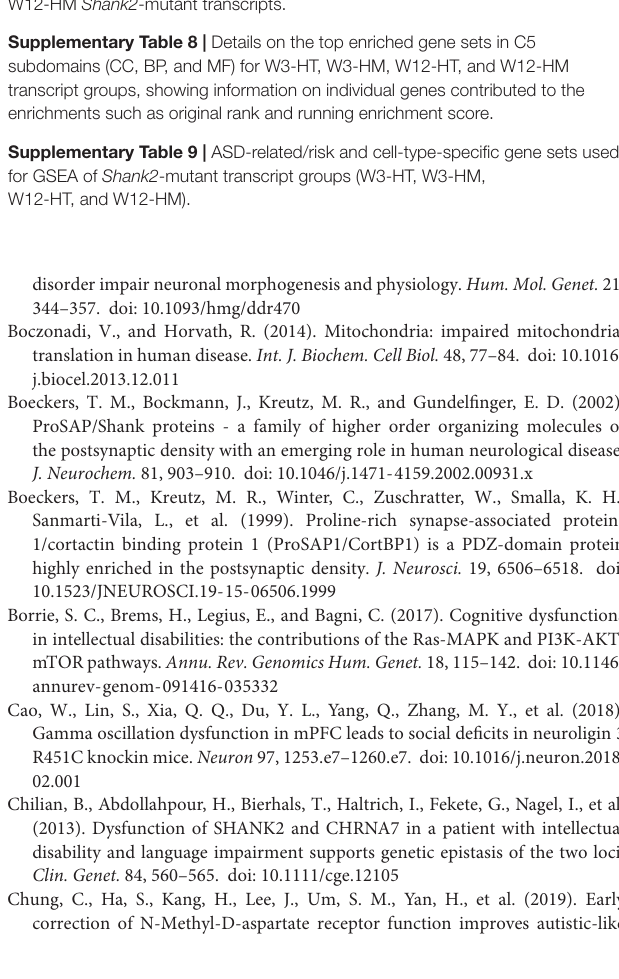
Supplementary Figure 2 | GSEA of transcriptomes from W3-HT Shank2 -mutant mice for biological functions in the C5-BP (biological process) domain. (A,B) GSEA results for W3-HT transcripts showing the list of top five positively (red) and negatively (blue) enriched gene sets (A) and their integrated visualization generated using Cytoscape EnrichmentMap App (B) ( n = 5 mice for WT, HT, and HM, FDR < 0.05). Supplementary Figure 3 | GSEA of transcriptomes from W3-HT Shank2 -mutant mice for biological functions in the C5-MF (molecular function) domain. (A,B) GSEA results for W3-HT transcripts showing the list of top five positively (red) and negatively (blue) enriched gene sets (A) and their integrated visualization generated using Cytoscape EnrichmentMap App (B) ( n = 5 mice for WT, HT, and HM, FDR < 0.05). Supplementary Figure 4 | GSEA of transcriptomes from W3-HM Shank2 -mutant mice for biological functions in the C5-BP (biological process) domain. (A,B) GSEA results for W3-HM transcripts (A) and their integrated visualization generated using Cytoscape EnrichmentMap App (B) ( n = 5 mice for WT, HT, and HM, FDR < 0.05). Supplementary Figure 5 | GSEA of transcriptomes from W3-HM Shank2 -mutant mice for biological functions in the C5-MF (molecular function) domain. (A,B) GSEA results for W3-HM transcripts (A) and their integrated visualization generated using Cytoscape EnrichmentMap App (B) ( n = 5 mice for WT, HT, and